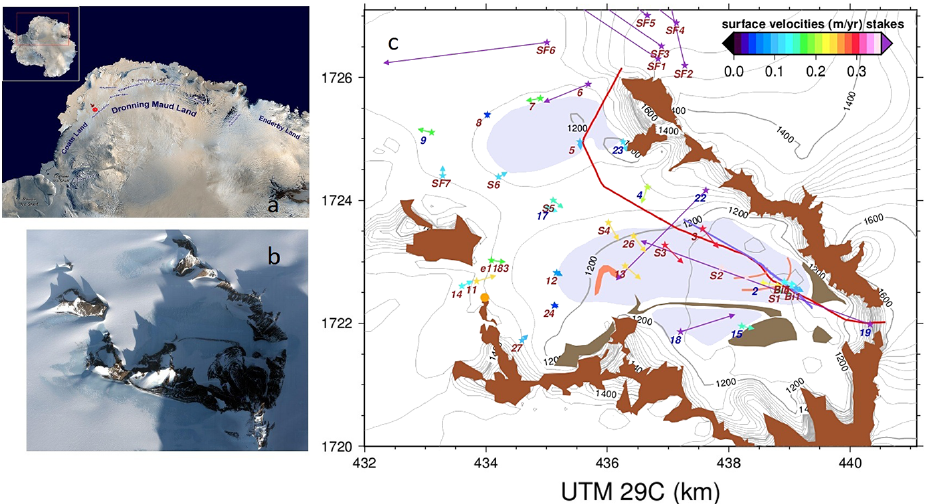
Fig. 1. Satellite pictures indicating (a) the position of Dronning Maud Land (credits Wikimedia Commons), with the SBB area indicated by the red dot, and (b) of the Scharffenbergbotnen (SBB) valley (NASA public imagery) and (c) a sketch of the domain augmented with observed stake and GPS velocities shown as arrows annotated by the stake reference code (red are GPS measurements, blue are theodolites) with corresponding stake positions as star and the color according to the velocity legend. GPS velocities are based on surveys using Svea station (large yellow circle) as the reference point. Geological and geographical features: brown rocks, dark-gray moraines, light-gray blue ice, orange lines distinctive features within the blue ice, long ice core in blue, position of the vertical transect for the flow-line model (red) within the area of SBB. All coordinates in this figure and also the following figures are defined by WGS84 UTM zone 29C.